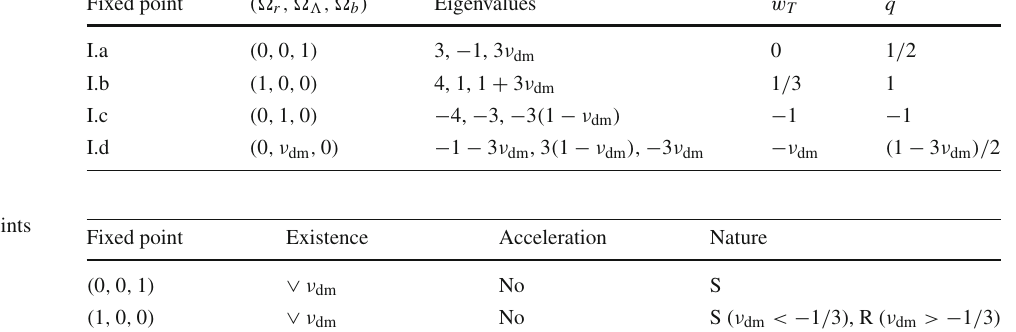
Table 1 Fixed points of model I